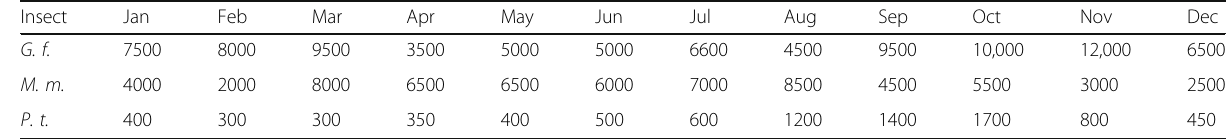
Table 1 Numbers of individuals of G. ficorum , M. moraguesi , and P. thysanopterus (over l00 infested leaves) in the year 2016 Insect